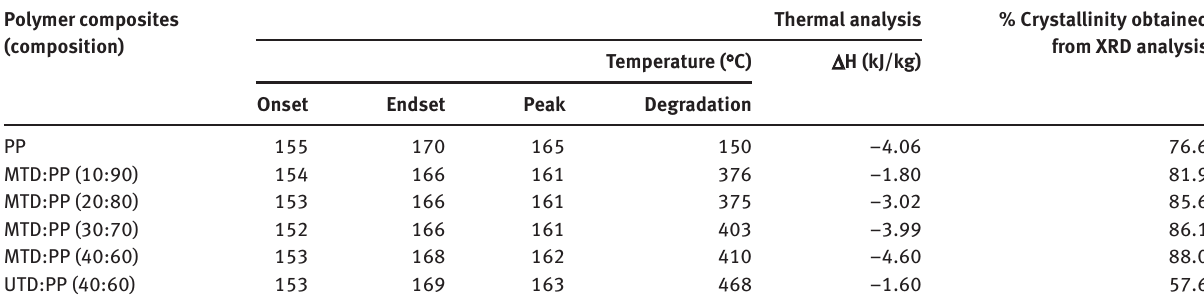
Table 1: Change in enthalpy, degradation temperature and crystallinity of TD:PP composites. Polymer composites Thermal analysis